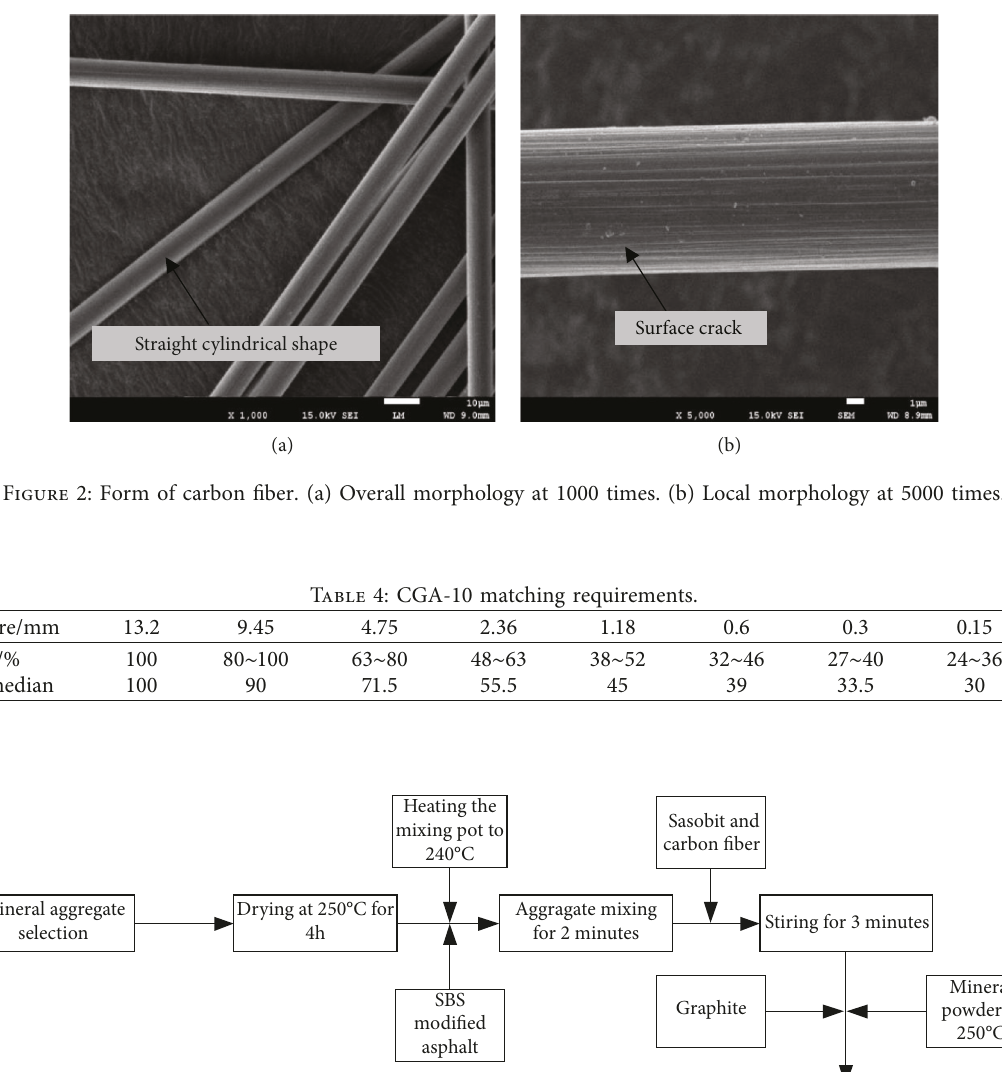
Mineral aggregate selection